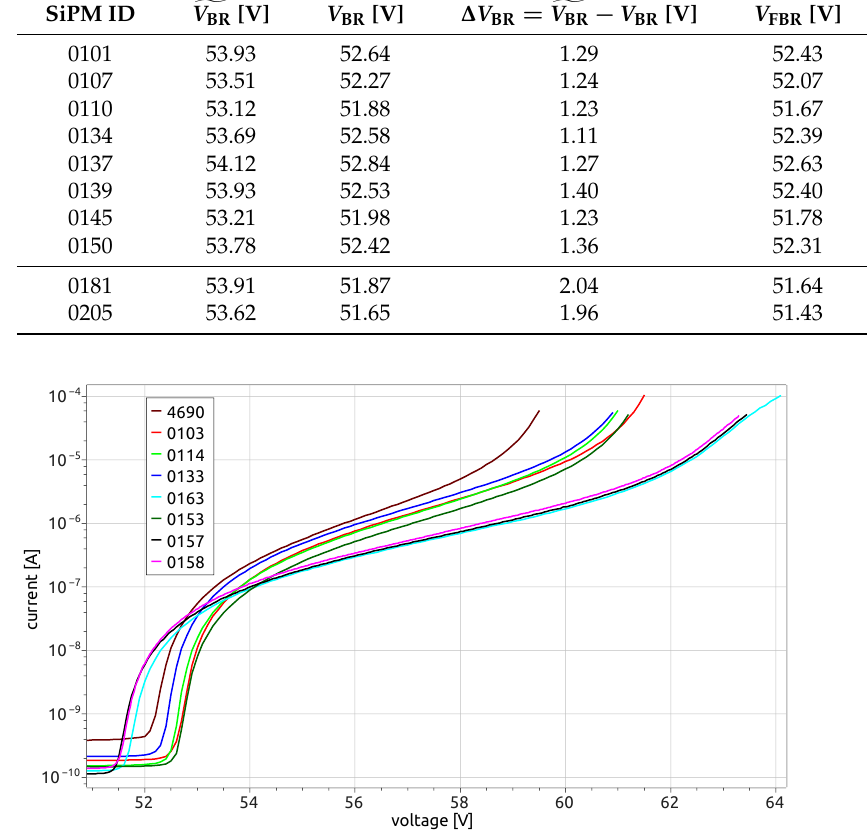
Figure 24. Current–voltage characteristics for various